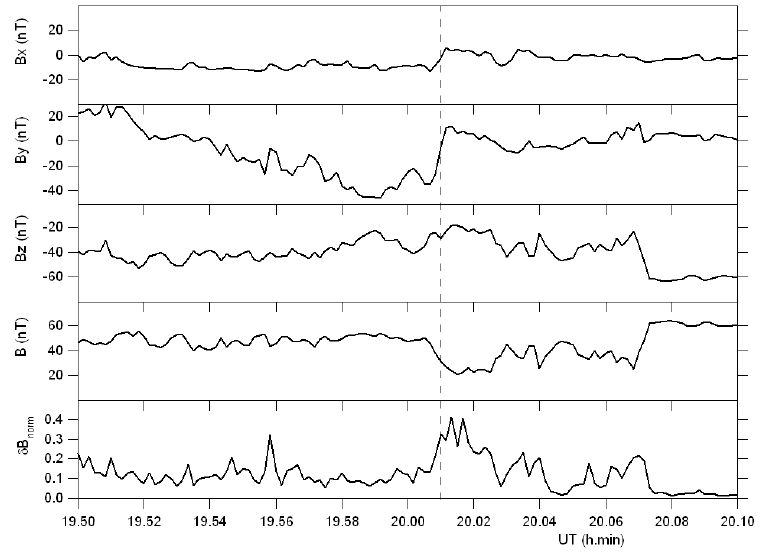
Fig. 1. Magnetic field components measured by the Cluster spacecraft during the 13 February 2001, magnetopause crossing, averaged over 10s. From top to bottom, the three magnetic field components in the GSM system, the magnetic field magnitude, and the fluctuation level δB normalized to the local magnitude are shown. The simulation box of the numerical study corresponds approximately to the measurements going from 20:00:30 UT to 20:01:30